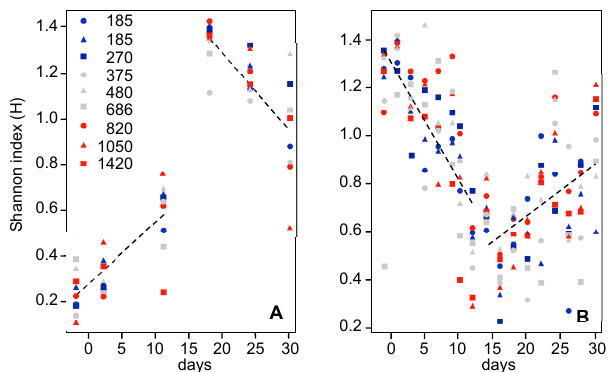
Fig. 5. Shannon indices ( H ) calculated for samples from the water column (A) and the sediment traps (B) . The numbers in the legend present initial CO 2 concentrations (µmol) after the CO 2 manipu- lation was completed. Linear mixed effects models (dotted lines) were fitted to determine the dependence of diversity H on time and on CO 2 as a linear response combined with two nutrient conditions ( t − 2 , t 2 and t 11 representative of phase 1 and t 18 , t 24 and t 30 repre- sentative of phase 2 and